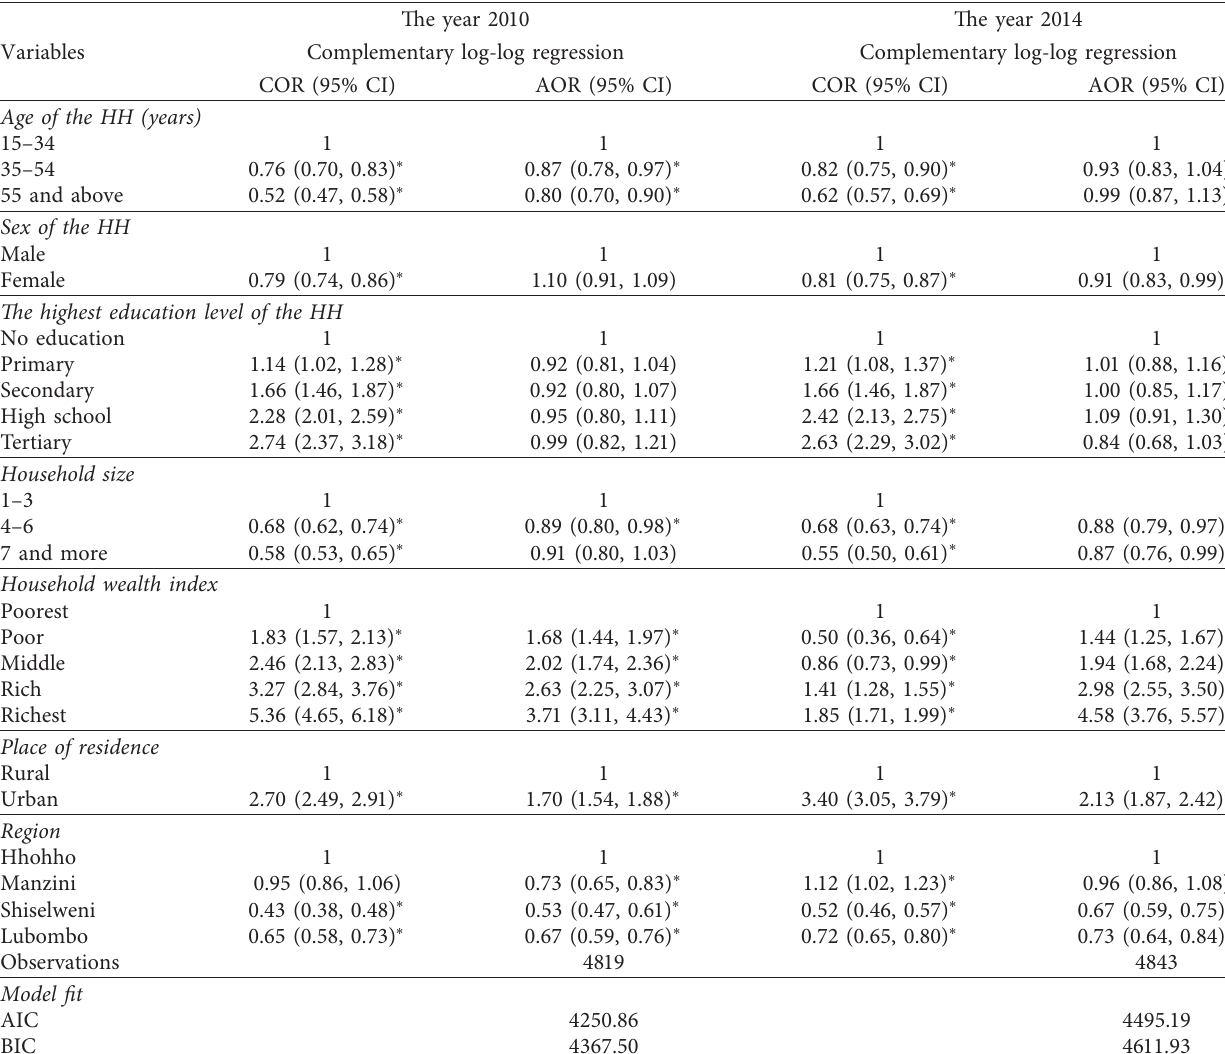
Table 3: Bivariate and multivariate results of the determinants of households’ access to improved drinking water sources in 2010 and